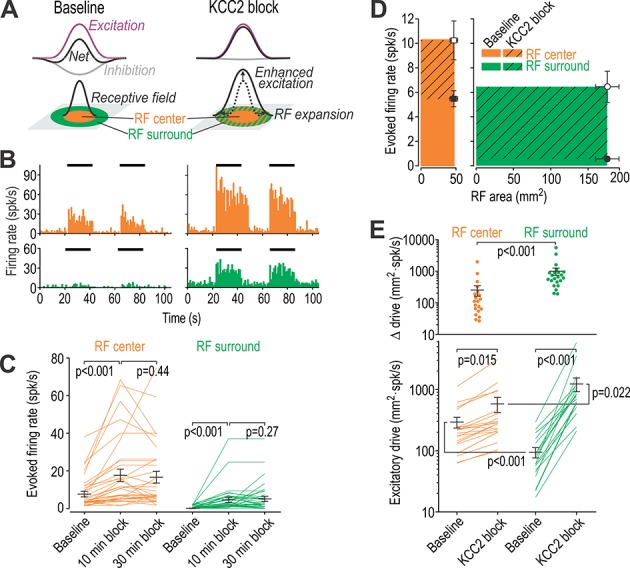
Disinhibition causes receptive fields to expand.(A) Cartoon depicts how narrowly tuned excitation combined with broadly tuned inhibition produces a receptive field (RF) with an excitatory center and inhibitory surround. (B) Firing rate histograms from a typical neuron responding to brush stimulation (black bars) applied to the RF center (orange) or surround (green) before (left) and after (right) blockade of KCC2 by intrathecal DIOA. (C) Summary of spike rates evoked by brush stimulation in the RF center or surround 10 and 30 min after application of 100 µM DIOA (n = 10) or 50 µM VU (n = 22) to block KCC2; data for DIOA and VU were pooled based on the absence of any significant differences. KCC2 blockade had a significant effect on brush-evoked firing (F2,62 = 17.78, p<0.001, two-way repeated measures ANOVA). Results of Wilcoxon tests are reported on graphs. Firing rates were stably elevated for at least 20 min, thus allowing for other effects of disinhibition (e.g. on RF size) to be measured. (D) To quantify the excitatory drive originating from each RF zone, average evoked firing rate (± sem) was plotted against average surface area (± sem) of the RF zone in which the stimulus was applied. Each data point demarcates a rectangle (colored) whose area is proportional to excitatory drive from that RF zone. (E) By calculating the product of RF zone area and firing rate on a cell-by-cell basis (n = 22), disinhibition was found to significantly increase total drive (F1,21 = 139.17, p<0.001; two-way repeated measures ANOVA on log-transformed data) but this depended on the RF zone (interaction, F1,21 = 49.81, p<0.001): the RF surround contributed significantly greater drive than the RF center after KCC2 blockade. Results of Student-Newman-Keuls (SNK) tests are reported on graphs.Figure 1—source data 1.Numerical values for data plotted in Figure 1.